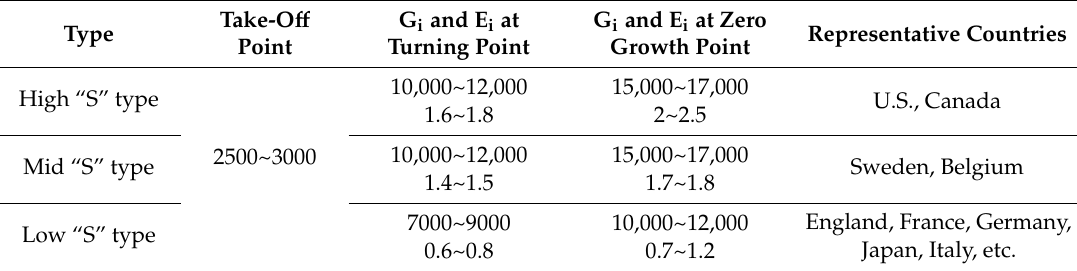
Table 2. Threshold GDP per capita levels for di ff erent